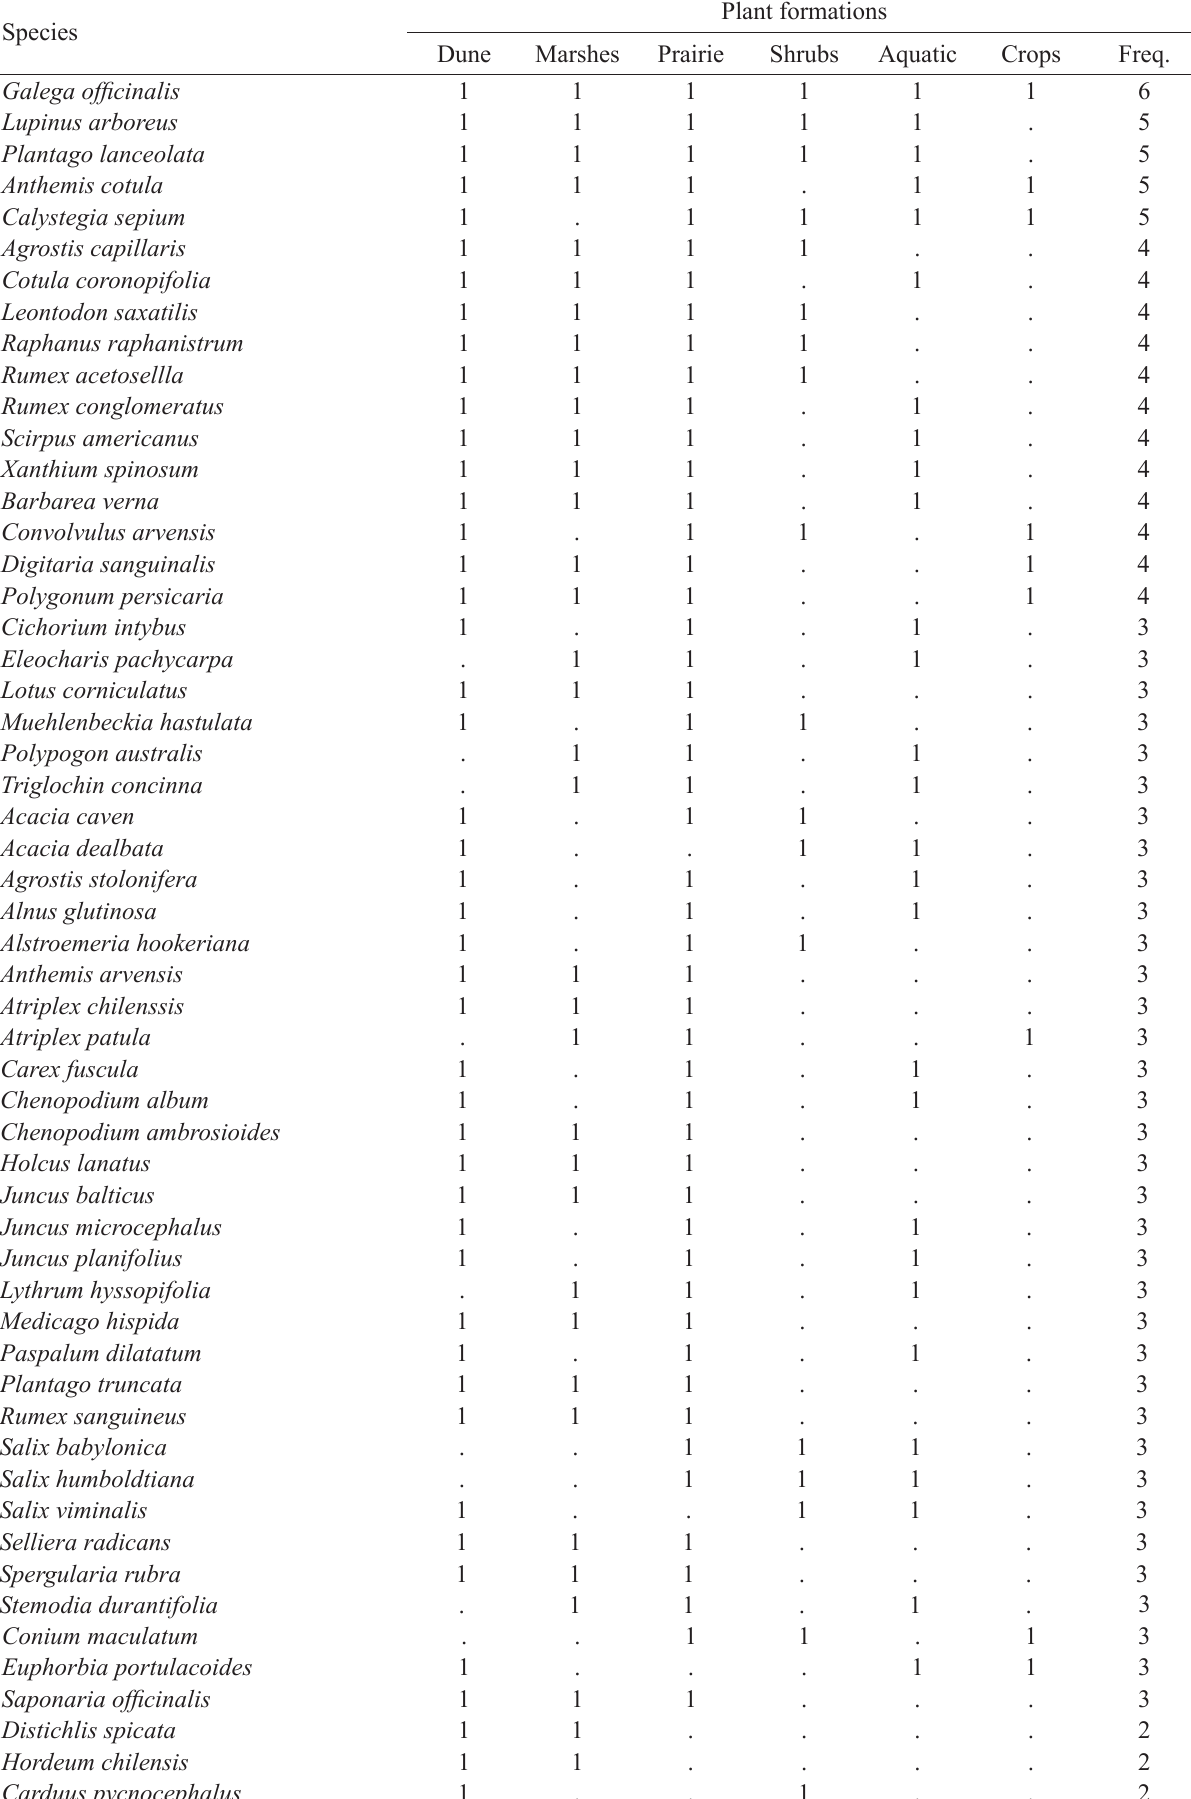
Table 3. Presence of the species in the plant formations ordered by frequency (Freq.). ‘1’ indicates presence of the species. Species